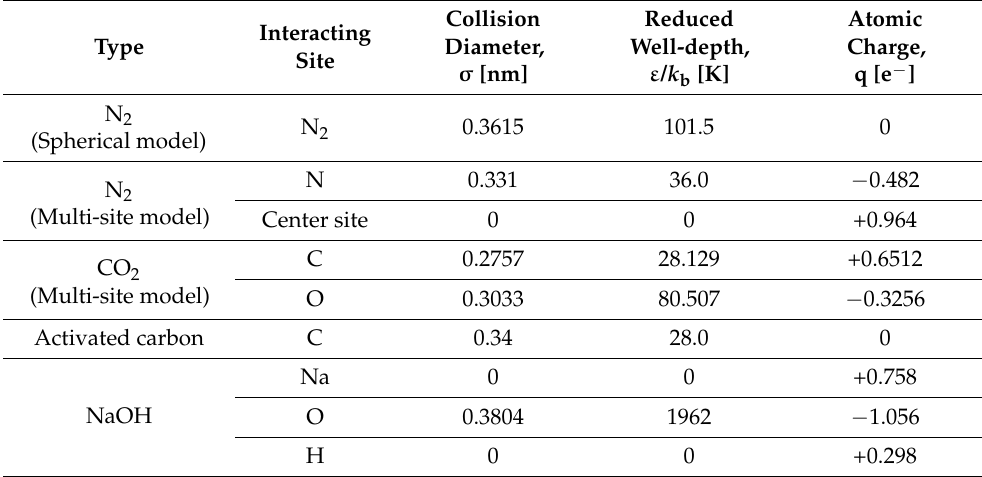
Table 1. Molecular parameters and atomic partial charges of N 2 , CO 2 , C, and NaOH used in the Grand Canonical Monte Carlo (GCMC)